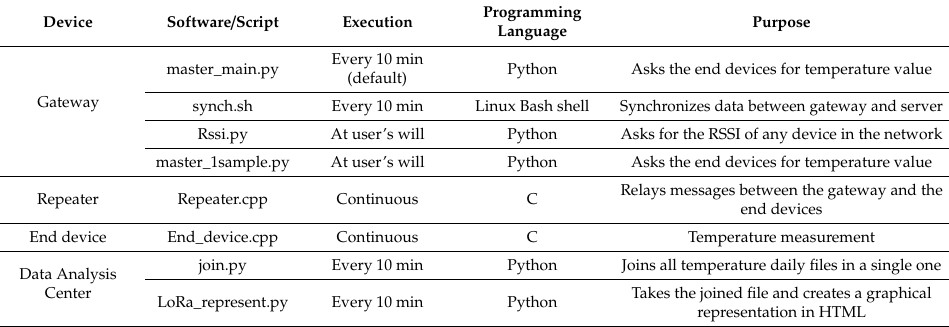
Table 5. Network software. RSSI: received signal strength indicators.